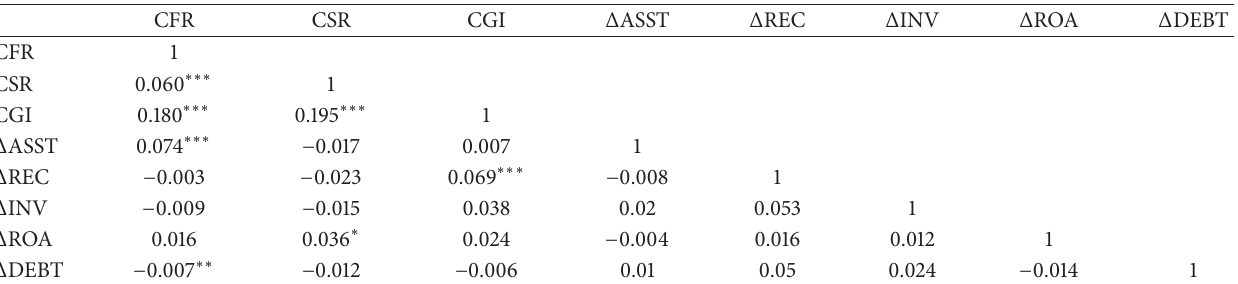
Table 6: Pearson correlation between variables.